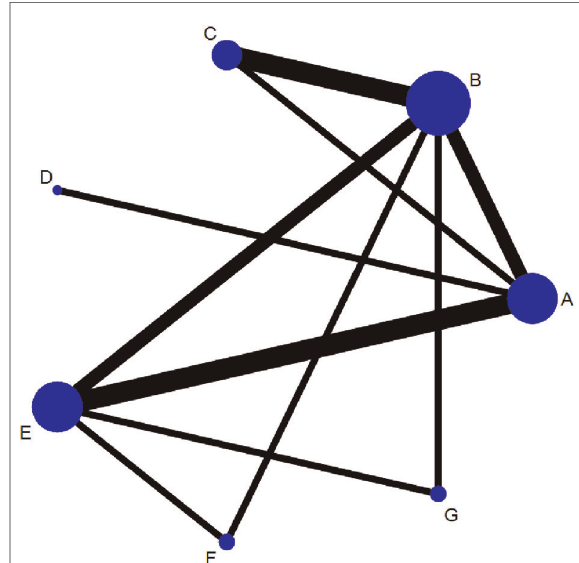
FIGURE 4 Networks for multiple treatment comparisons of cure rate. Lines between points indicate evidence of direct comparisons between two interventions. The thickness of lines indicates the number of studies using the two treatments, whereas the size of the dots indicates the total sample size of the intervention. ( A ) fresh fecal bacteria; ( B ) frozen fecal bacteria; ( C ) lyophilized fecal bacteria; ( D ) autologous fecal bacteria; ( E ) vancomycin; ( F ) fi daxomicin; ( G ) rectal bacteriotherapy.